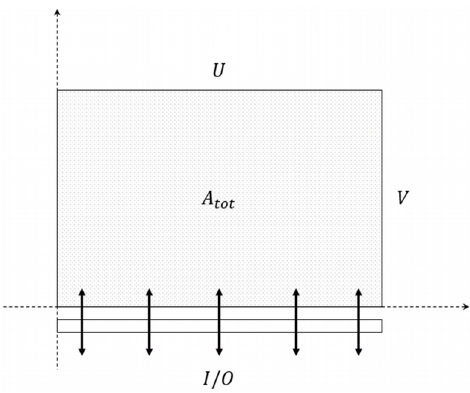
Figure 1. Storage area layout scheme ( U = storage area width; V = storage area length;